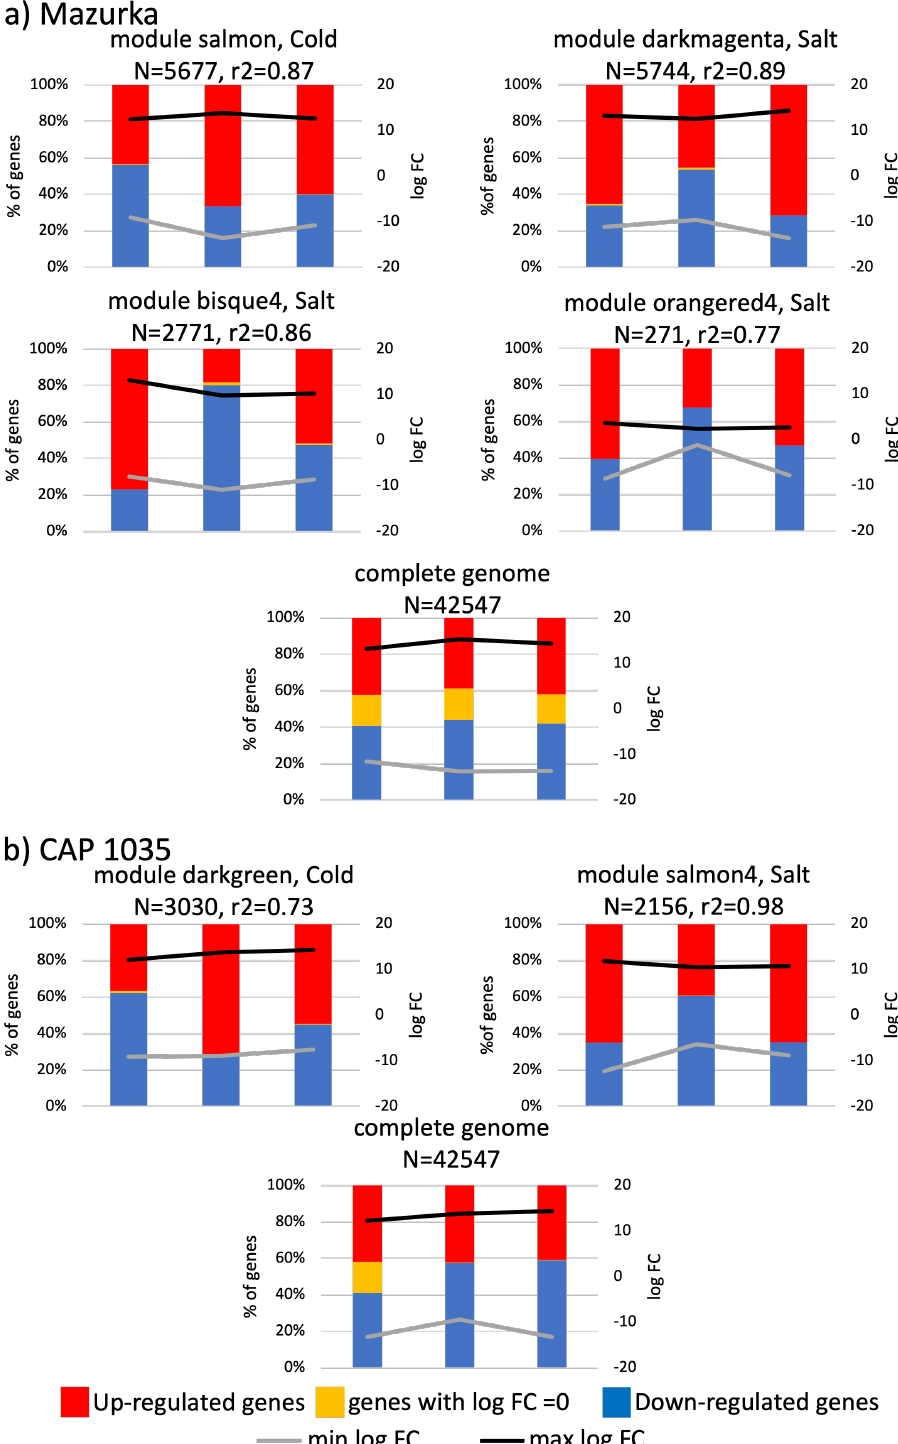
Figure A10. Characteristics of modules from the transcriptome with a high correlation for one binary trait shown for Mazurka (a) and CAP 1035 (b) at d14. RNASeq data was used to perform a weighted cluster analysis. Modules with a correlation of 0.73 and higher were investigated for the presence of up- (red) or down-regulated (blue) genes. Genes having a log 2 FC = 0 are indicated in yellow. The absolute maximal log 2 FC (black line) and minimal log 2 FC (grey line) are indicated. Beneath the module name is shown the number of genes within the module. The graph on the bottom shows data for the whole genome.